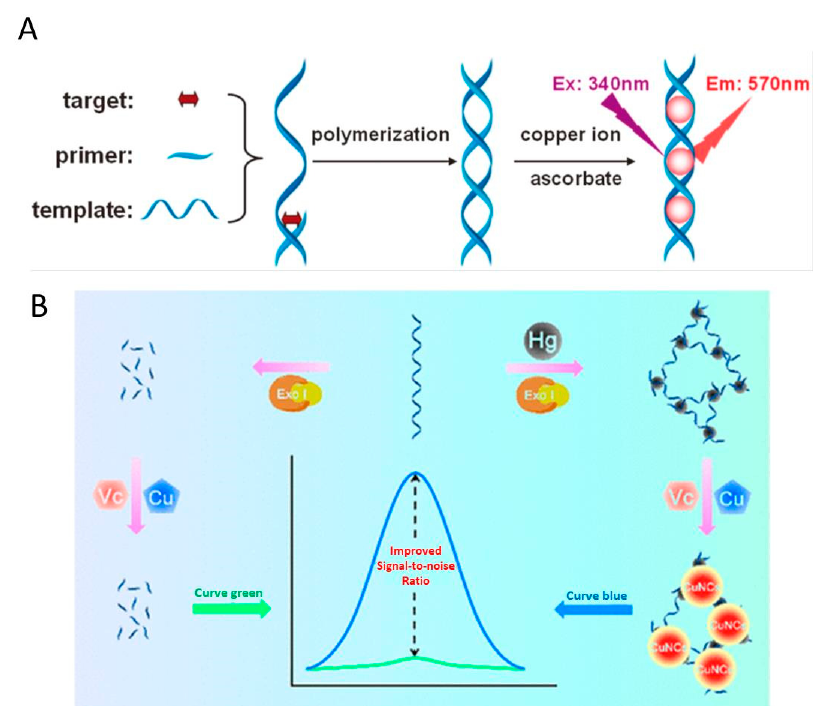
Figure 7. Schematic representation for ( A ) A turn-on strategy for polymerization-mediated Hg 2 + detection based on dsDNA-templated F-CuNCs. Reprinted with permission from Ref. [42]. Copyright 2014, Royal Society of Chemistry; ( B ) A high signal-to-noise ratio strategy for Hg 2 + sensing that based on rigid reticular DNA templated F-CuNCs. Vc is the abbreviation of ascorbate, and Exo I is the abbreviation of exonuclease I. Reprinted with permission from Ref. [68]. Copyright 2018, American Chemical Society.